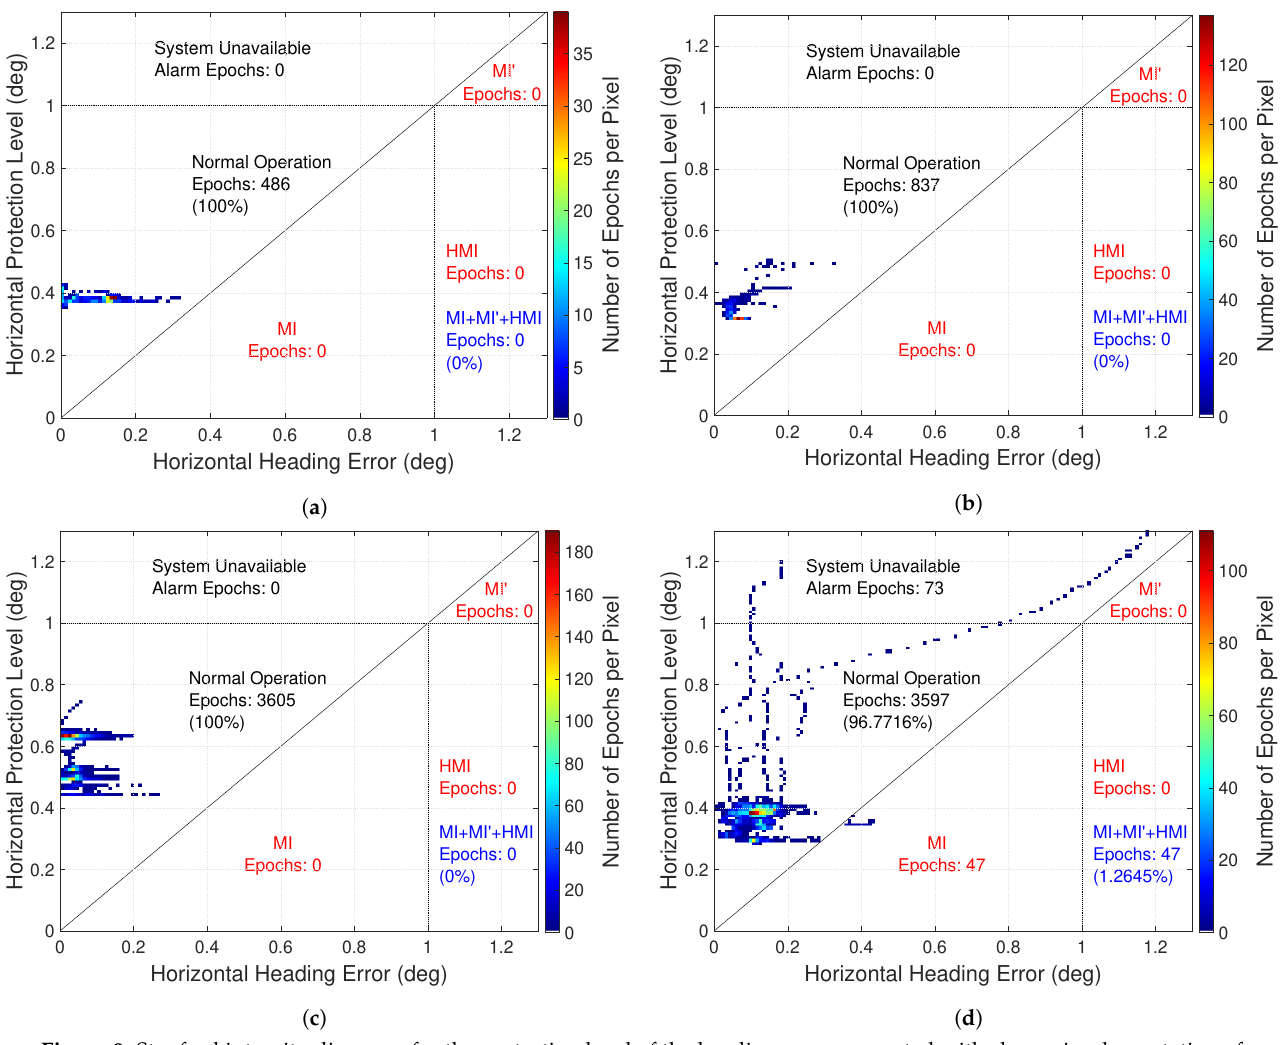
Figure 8. Stanford integrity diagrams for the protection level of the heading error computed with chosen implementation of KIPL integrity algorithm in the four selected scenarios: ( a ) airfield, ( b ) highway, ( c ) country road and ( d )